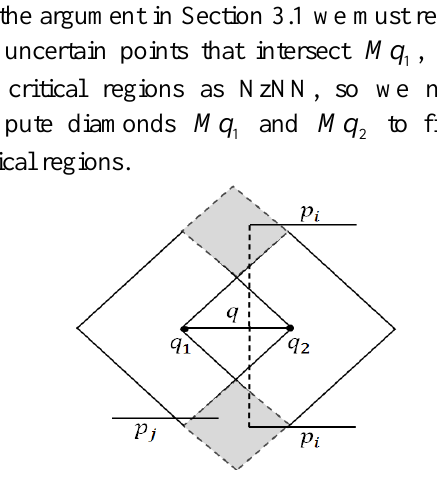
p with respect to query point q . i